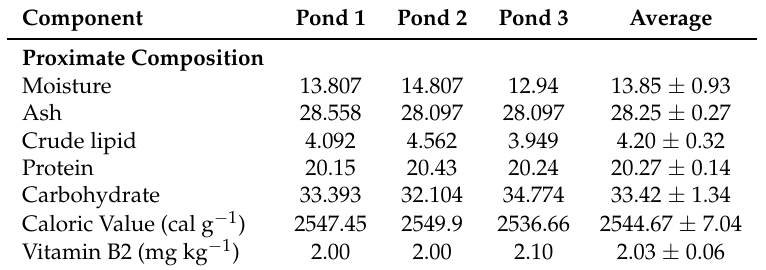
Table 2. The proximate composition of cultivated C. racemosa (%, w/w on the dry